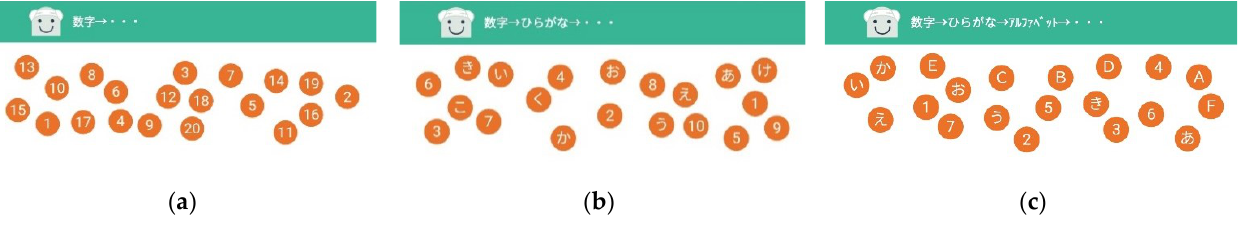
Figure 2. TMT of tablet manufactured by NeU using in the study. ( a ) TMT-A, ( b ) TMT-B, ( c ) TMT- C. TMT-A is task to draw a line connect numbers. The TMT-B, which includes a task to connect numbers and letters of Japanese (hiragana), and TMT-C, which includes a task to connect numbers, hiragana, and alphabets in order, were also conducted.